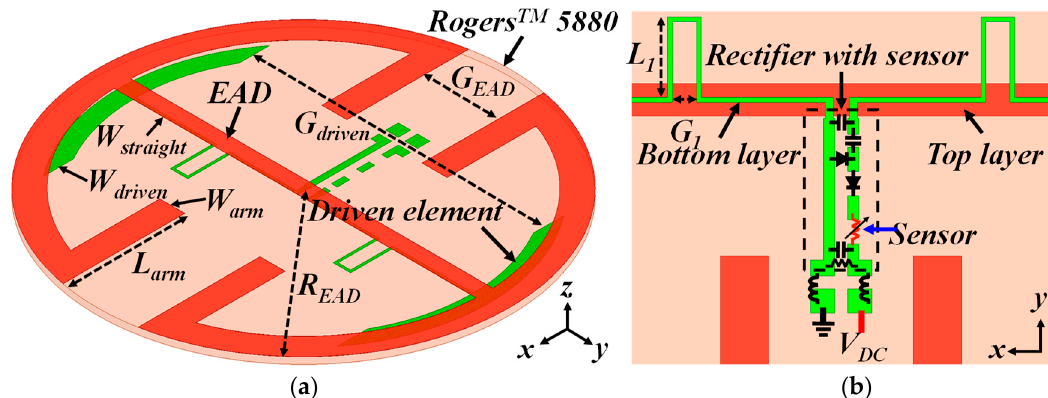
Figure 2. Electrically small ( ka < 0.5) Egyptian axe dipole (EAD) antenna integrated with a sensor-augmented rectifier: ( a ) perspective view and ( b ) bottom view.